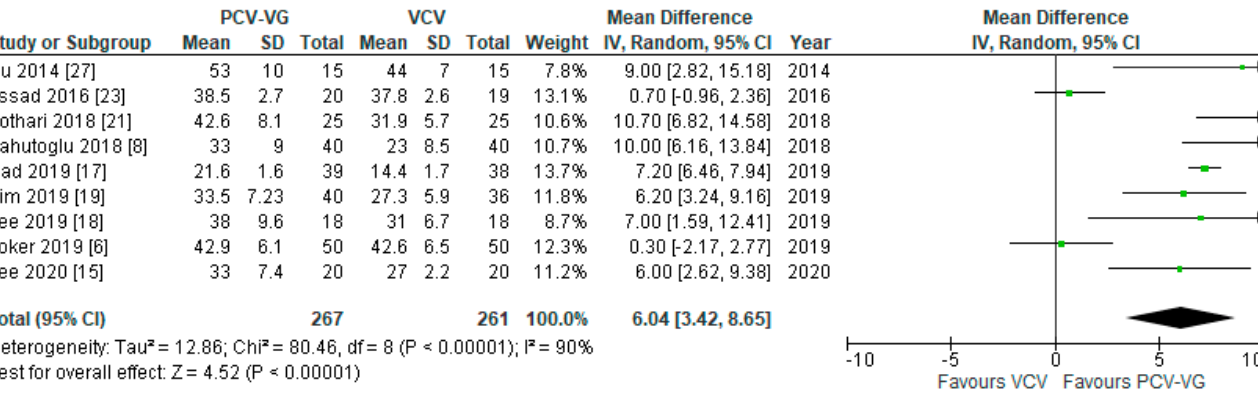
Figure 6. Mean airway pressure (P mean ): supine, two-lung ventilation. The green center of each square represents the weighted mean difference for individual trials, and the corresponding horizontal line stands for a 95% confidence interval. The diamonds represent pooled results.